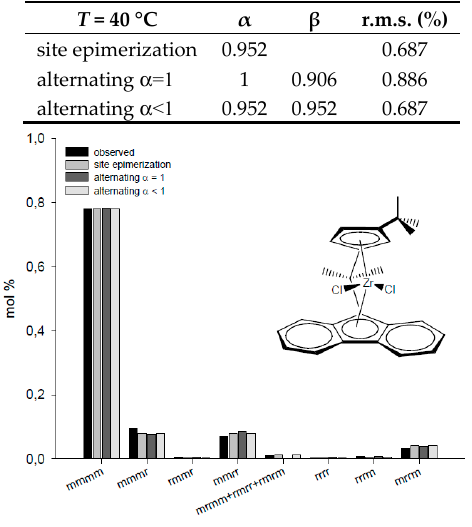
Figure 4. Statistical pentad analysis of a polypropene sample prepared with 4 /MAO at 40 °C [4,20].